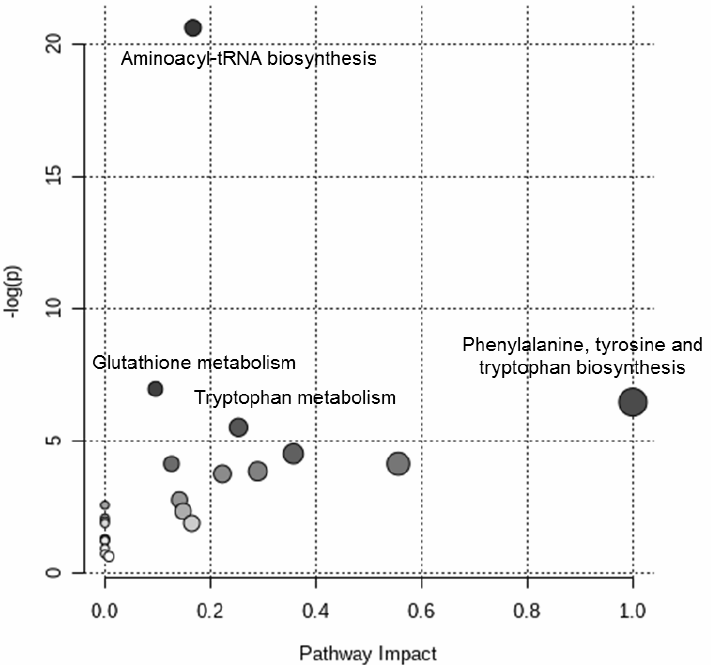
Table 3. Relevant metabolites for blood samples. SEPSIS > CTRL indicates that the mean in the EOS group is higher than in the control group. HMDB ID: identifier used in the Human Metabolome Database. AUC (CI 95%): confidence interval at the level of 95% of the area under the receiver operating characteristic (ROC) curve.